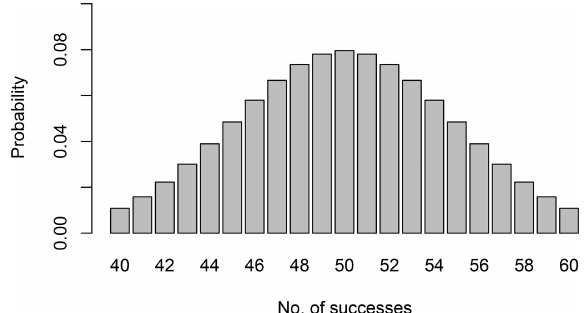
Figure 1. Binomial probability distribution for obtaining between 40 and 60 successes in 100 trials when the probability of success is 0.5. The probabilities for each outcome are calculated using Eq.